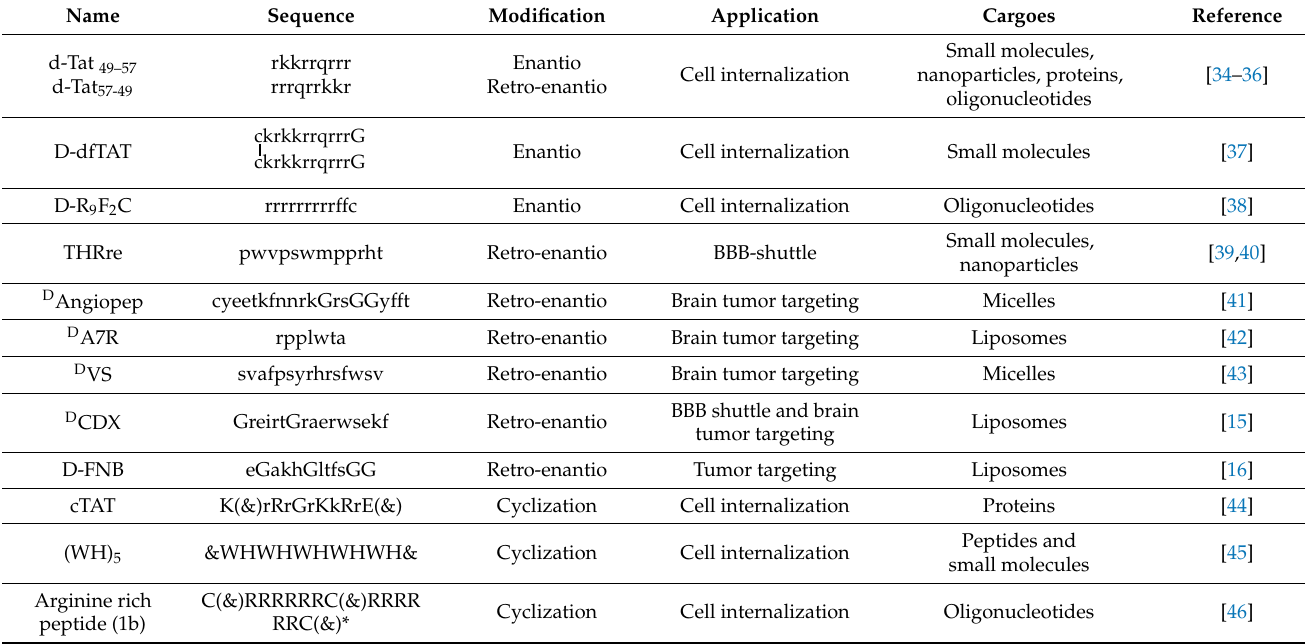
Table 1. Representative enantio/retro-enantio and cyclic targeting and cell-penetrating peptides.